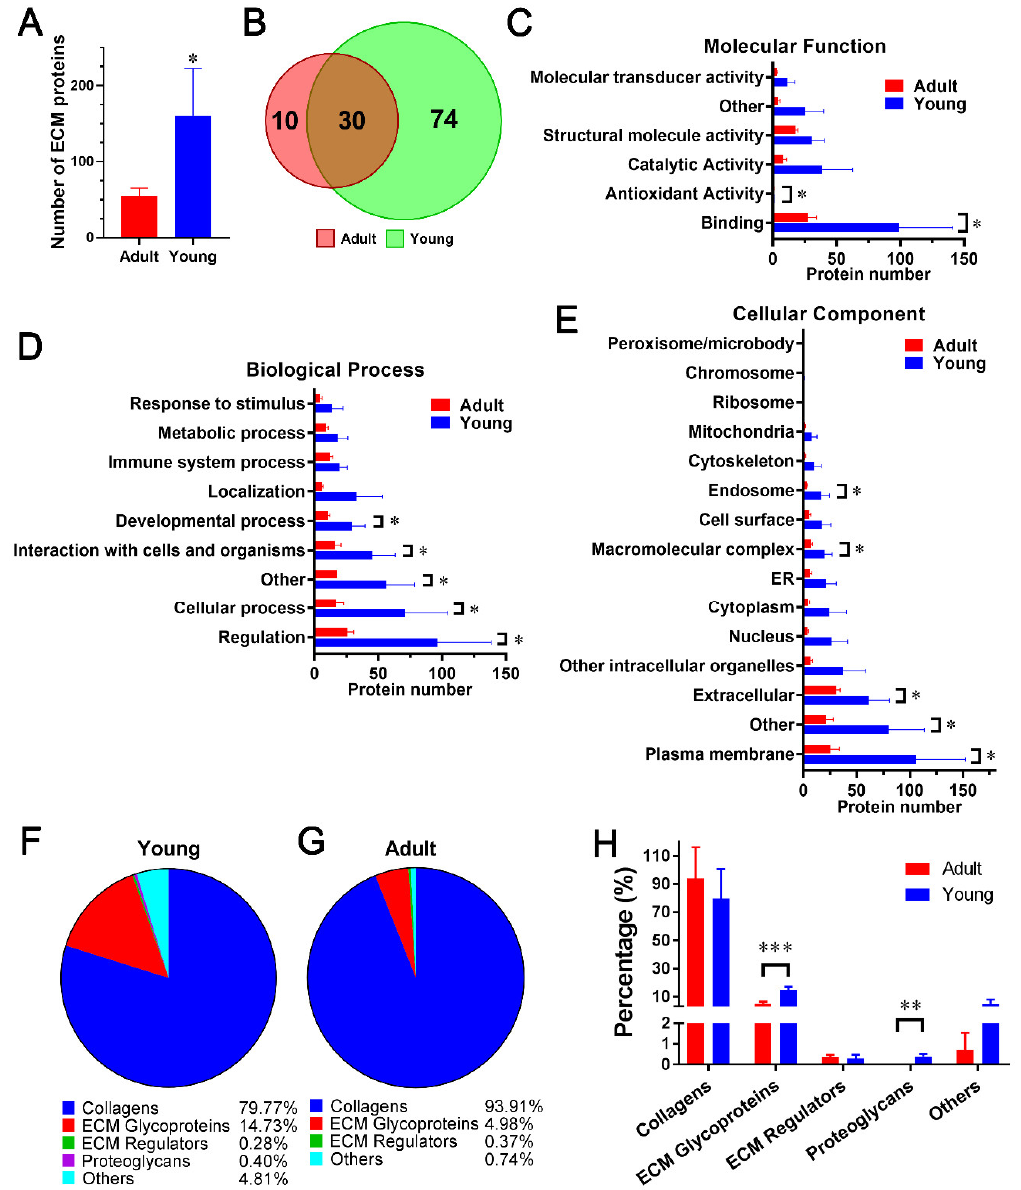
Figure 3. Comparison of dpECM proteins detected in young and adult porcine pancreata. ( A ) Average number of proteins identified in adult ( n = 4) and young ( n = 4) dpECM. *: p < 0.05. ( B ) Venn diagram showing total numbers of extracellular proteins commonly identified in the adult and young dpECM. ( C – E ) GO enrichment analysis of proteins identified in the dpECM assigned to molecular function ( C ), biological process ( D ), and cellular component ( E ). *: p < 0.05. ( F , G ) Proteins in young ( F ) and adult ( G ) dpECM involved in the developmental process were classified into indicated matrisome subcategories. ( H ) Percentage of protein abundance in the total abundance of dpECM proteins involved in the developmental process. **: p < 0.01; ***: p < 0.001. Data are shown as mean ± SD.